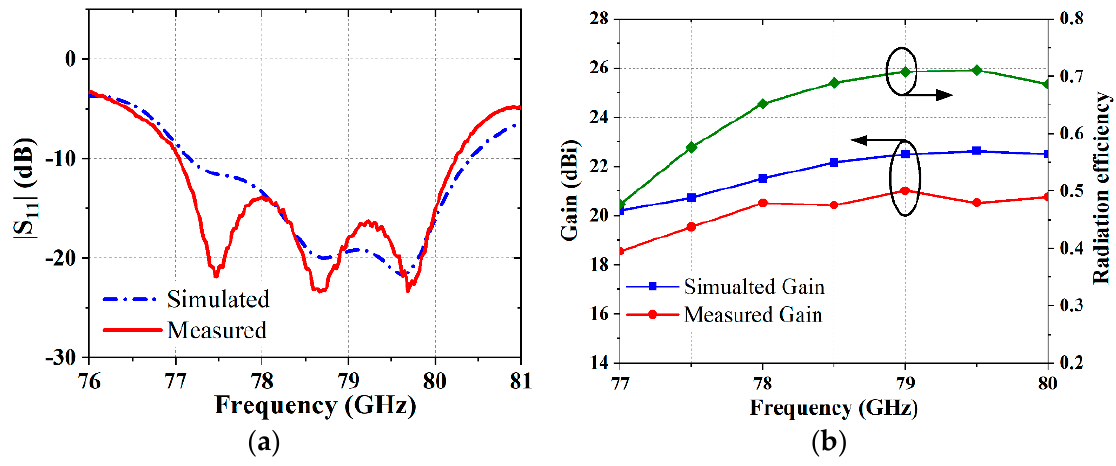
Figure 16. Experimental and simulated data. ( a ) |𝑆 (cid:2869)(cid:2869) | . ( b ) Gain and radiation efficiency.